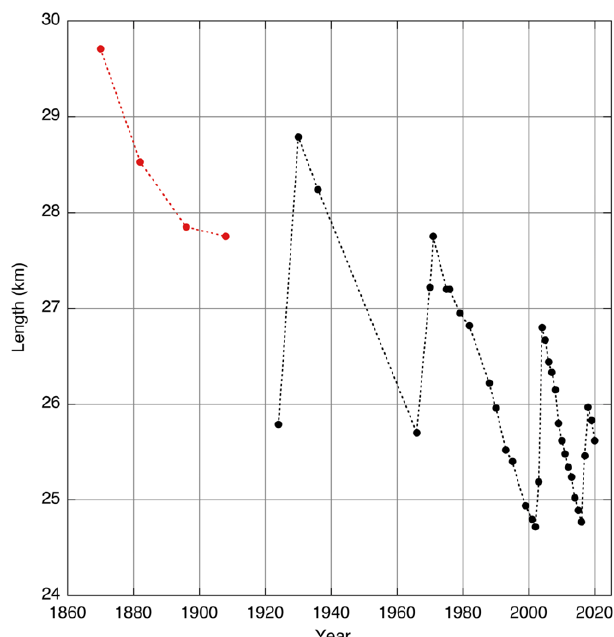
Figure 2. Length of Tunabreen from historical documents, aerial photographs, and satellite images (Flink et al., 2015, with addi- tions). The first four data points in red refer to the period that Tunabreen and Von Postbreen formed a joined front.